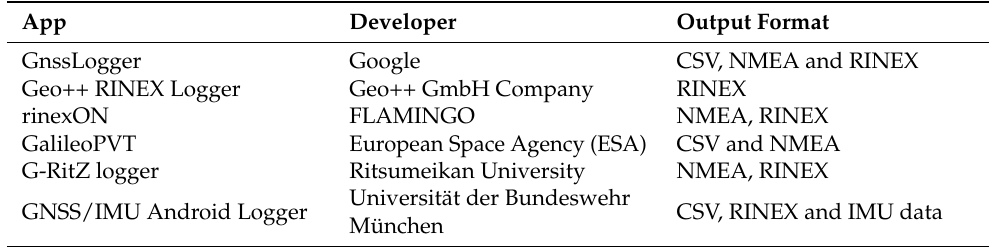
Table 1. Available GNSS logger Android applications [20]. App Developer Output